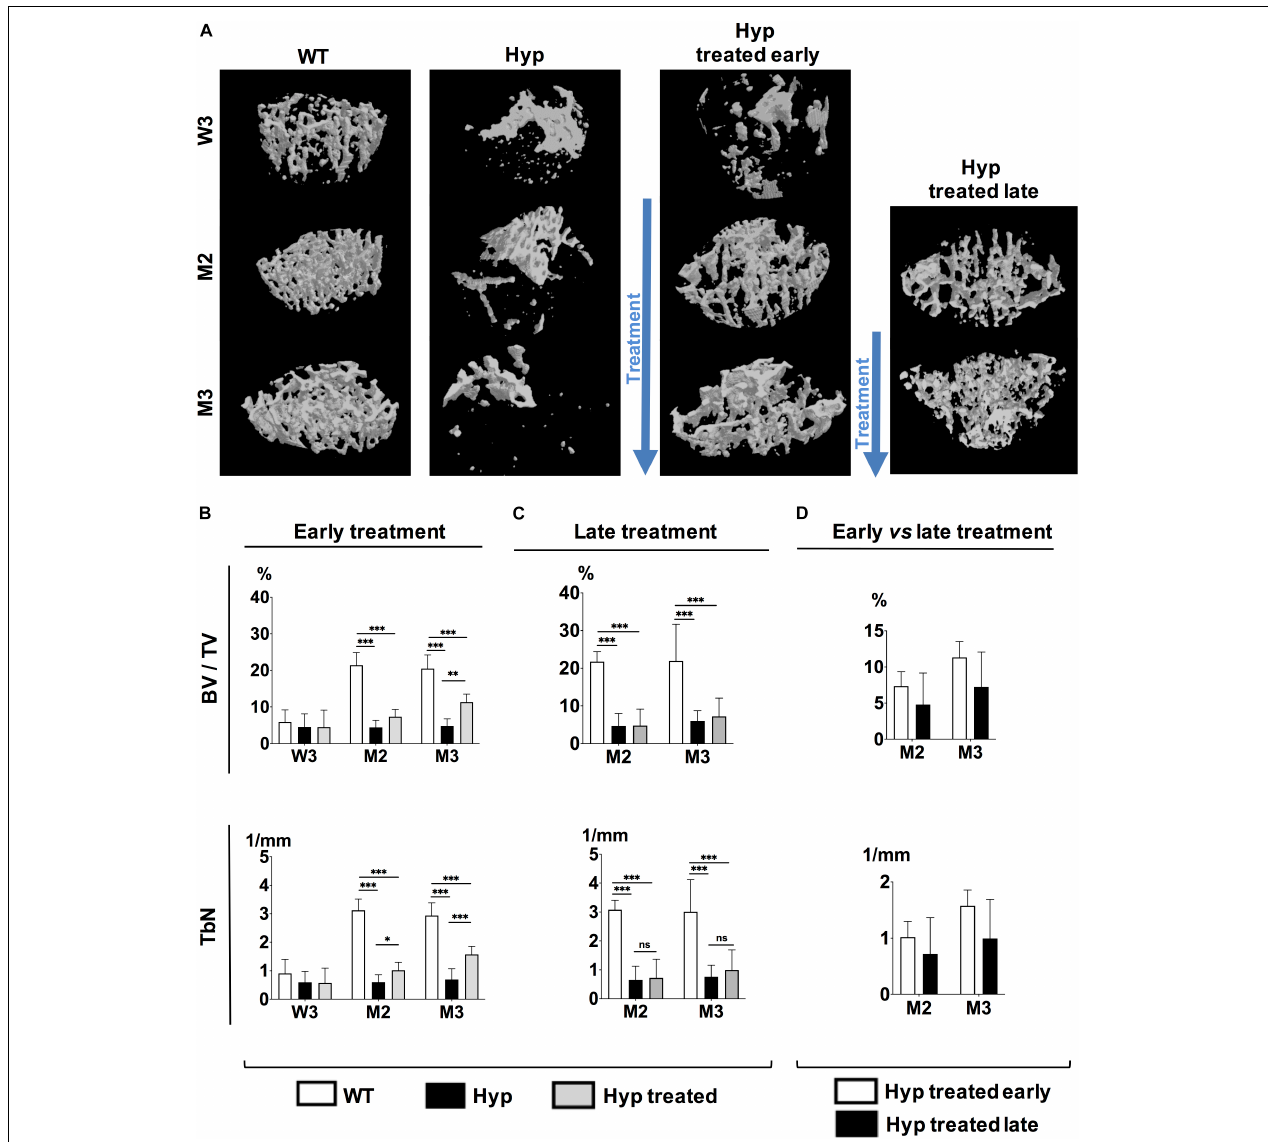
FIGURE 2 | Parameters of bone microarchitecture evaluated with micro-CT in WT mice, untreated Hyp mice, and Hyp mice on conventional treatment started early and late. (A) 3D-images of bone microarchitecture at baseline (W3), M2 and M3 in WT mice, untreated Hyp mice, and Hyp mice on conventional treatment started early, and at M2 and M3 in WT mice, untreated Hyp mice, and Hyp mice on conventional treatment started late. (B) BV/TV and TbN at baseline (W3), M2 and M3 in WT mice, untreated Hyp mice, and Hyp mice on conventional treatment started early. (C) BV/TV and TbN at baseline (M2) and M3 in WT mice, untreated Hyp mice, and Hyp mice on conventional treatment started late. (D) BV/TV and TbN at M2 and M3 in Hyp mice on conventional treatment started early compared to Hyp mice on conventional treatment started late. BV/TV, bone volume/total volume ratio; TbN, trabecular number. W3: 3 weeks; M2: 2 months; M3: 3 months; * p < 0.05; ** p < 0.01; *** p <